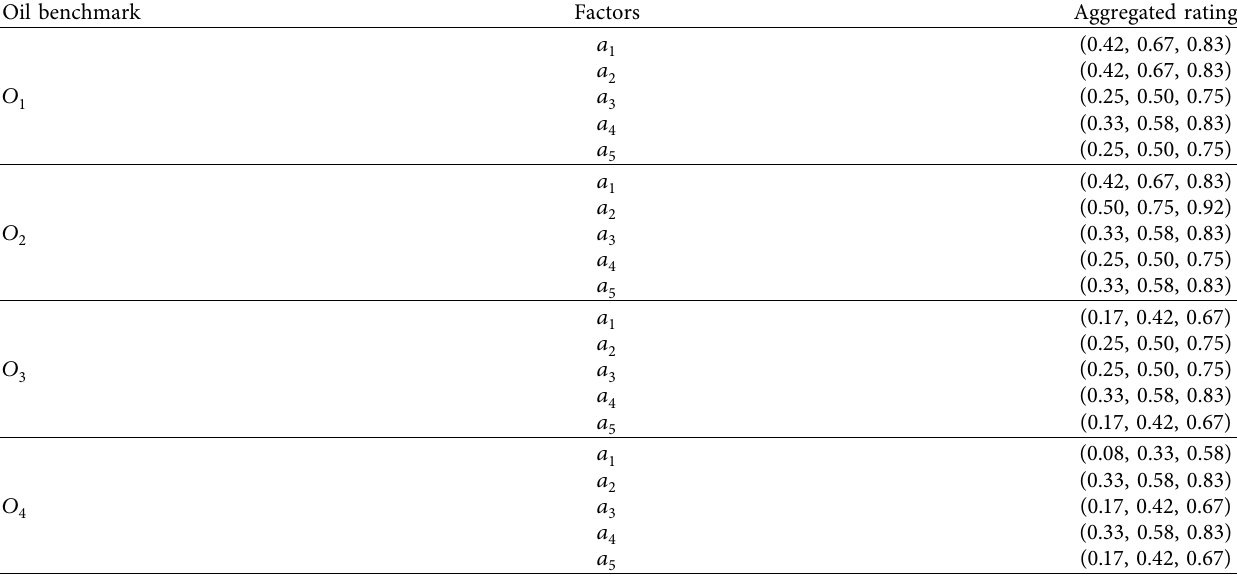
Table 8: Aggregated fuzzy rating of a factor with respect to criteria.